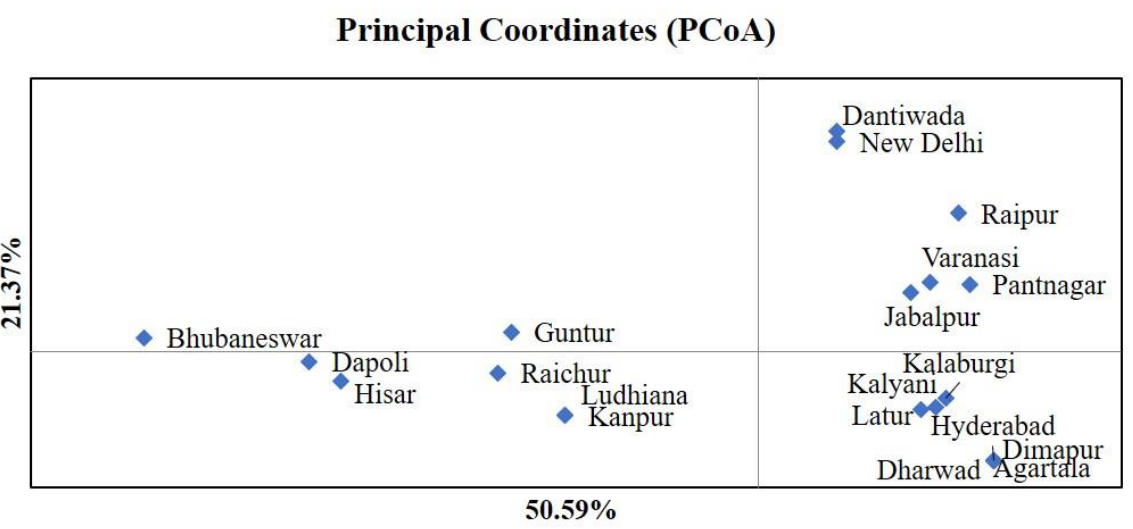
Figure 3. PCoA analysis score plot of M. vitrata populations from different locations across India based on COI gene.